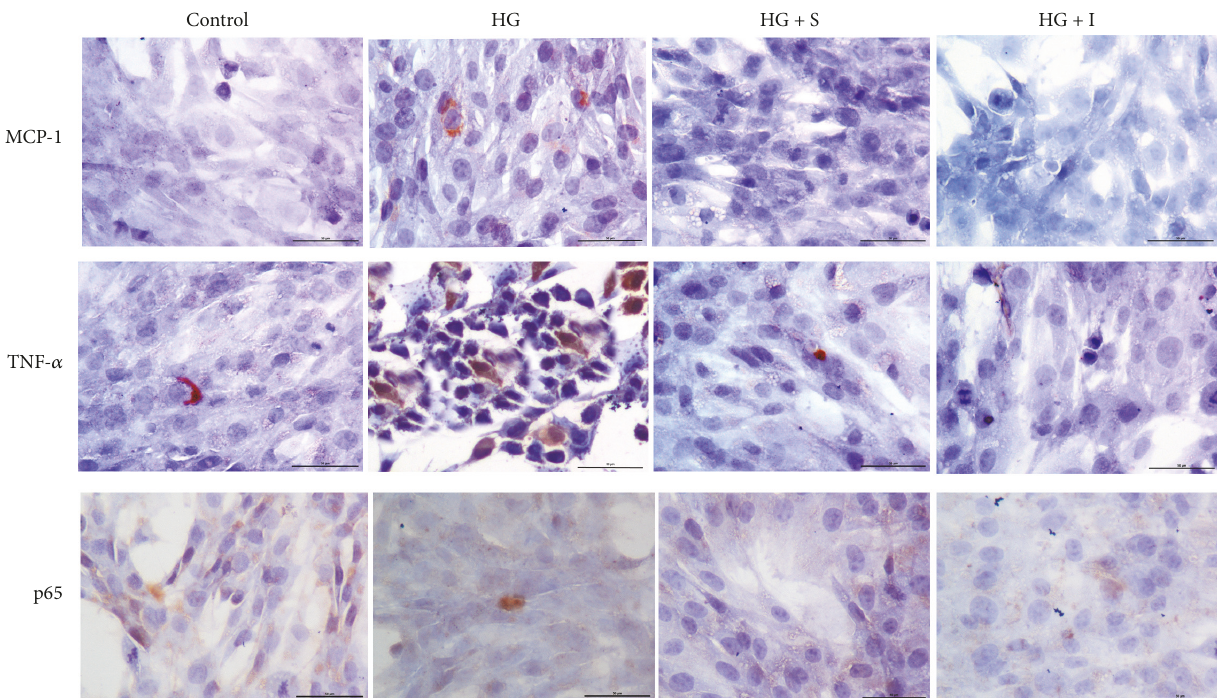
Figure 4: SYFSF inhibited the expression of in fl ammatory cytokine in high-glucose-treated mesangial cells. High glucose induced upregulation of MCP-1 and TNF- α which were suppressed by SYFSF serum in mesangial cells. There was no obvious change of NF- κ Bp65 expression. HG +S represents the mesangial cells treated with high-glucose medium and serum from rats treated with SYFSF. HG+ I represents the mesangial cells treated with high-glucose medium and serum from rats treated with